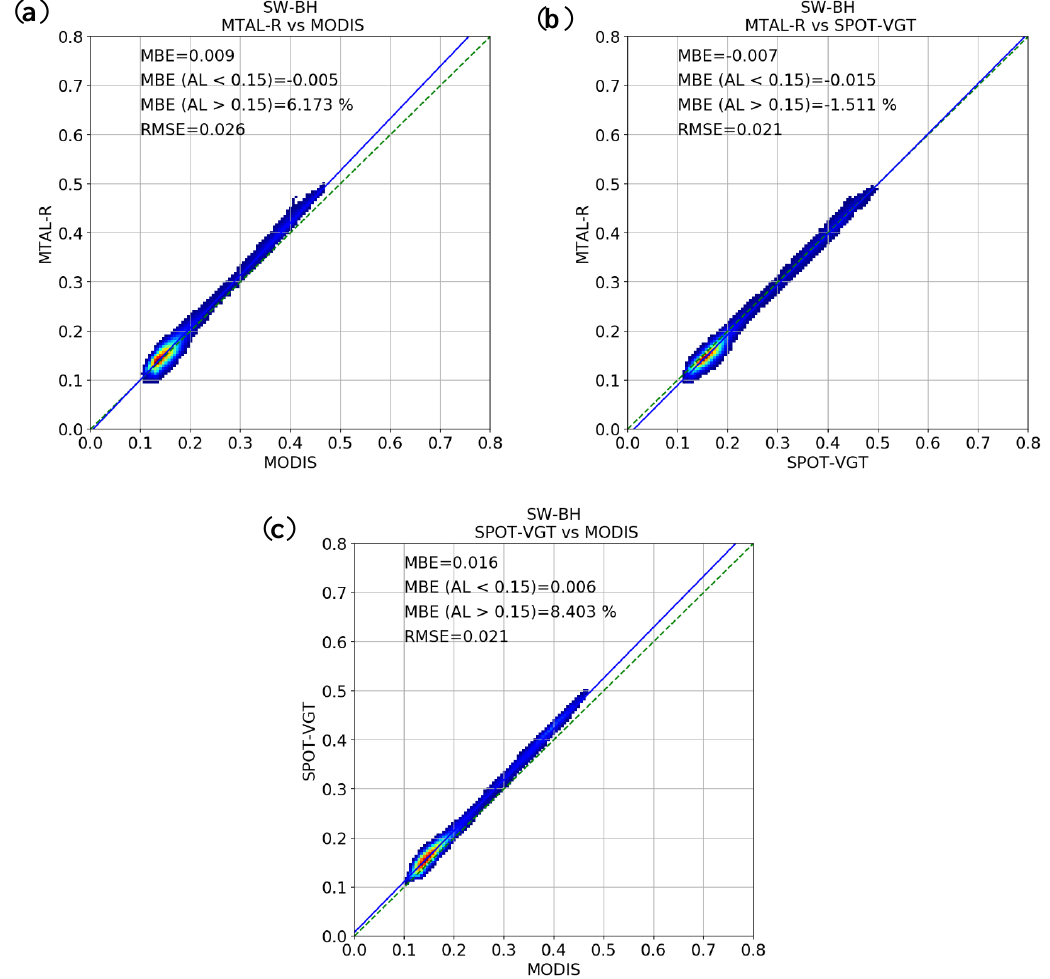
Figure 10. Density scatter plots for the inter-comparison of ( a ) MTAL-R versus MODIS; ( b ) MTAL-R versus SPOT-VGT and ( c ) SPOT-VGT versus MODIS during the period 2012.